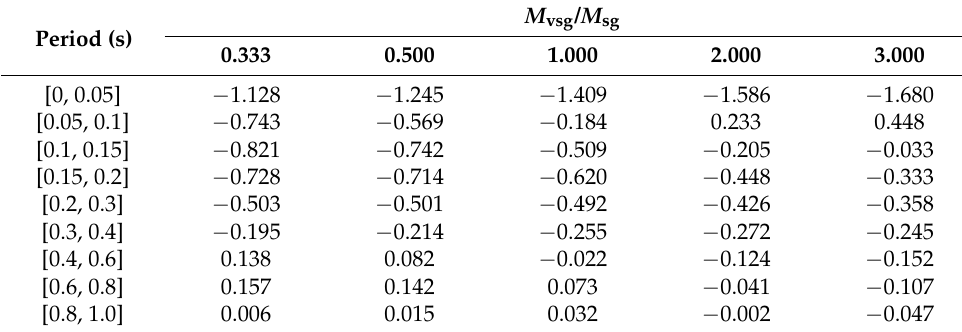
Table A5. Rate of change of frequency (RoCoF) (Hz/s) ( M vsg was changed).